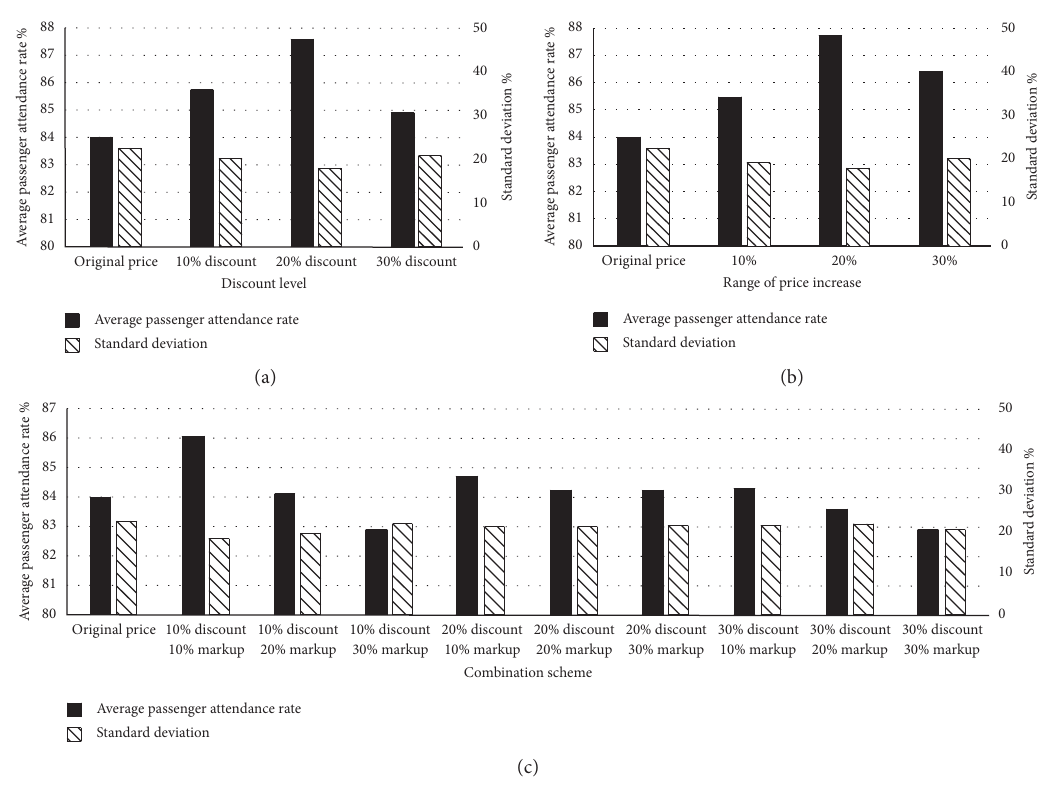
Figure 7: Occupancy rate and standard deviation under different fare